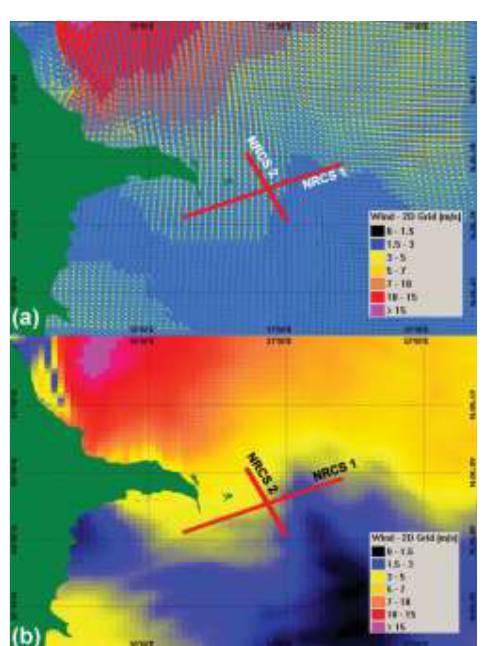
Figure 13. Wind speed from OSCAR System for 18 May 2009 at 18:29; (a) vector model and (b) grid